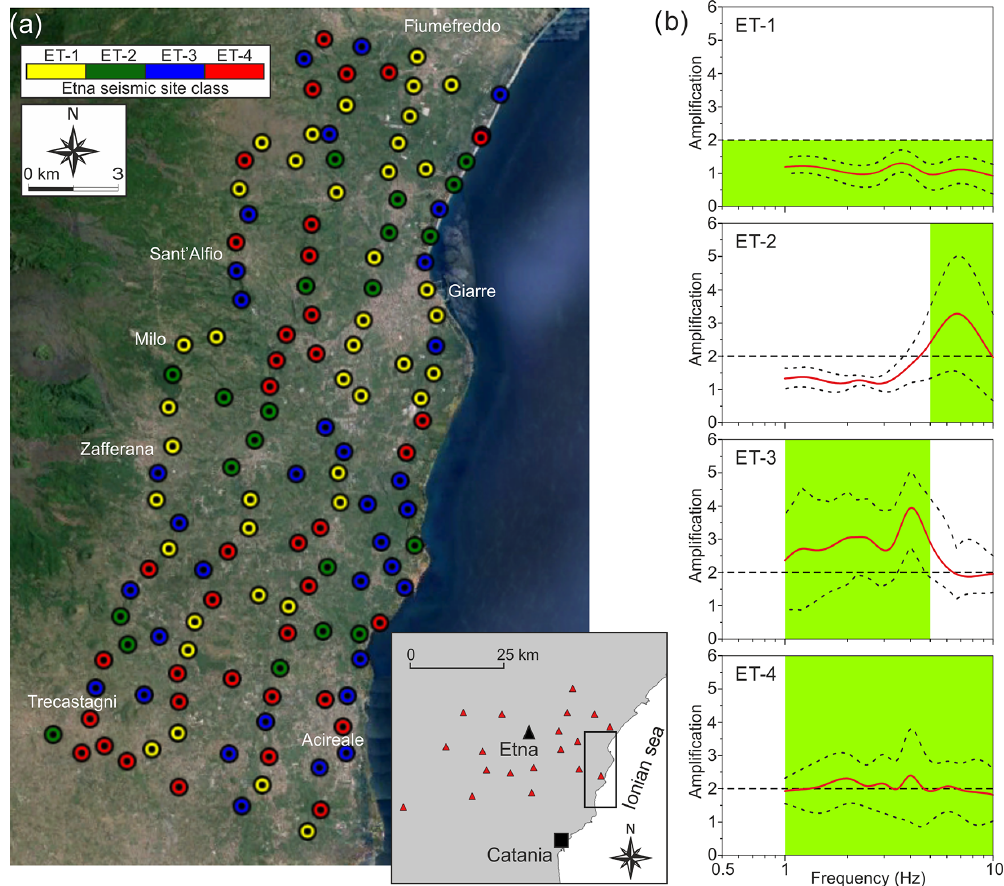
Figure 7. Site amplification at Mt. Etna. (a) Sites investigated by HVNR measurements, where different colors point out the assigned “spectral class” given in the legend. In the inset map, location of the investigated area (black rectangle) and seismic stations (red triangles) used for the evaluation of the site amplification functions. (b) Site amplification functions (mean value in red, standard deviation with dashed black curves; see also Longo, 2017) obtained by grouping the HVSR inversions of seismic